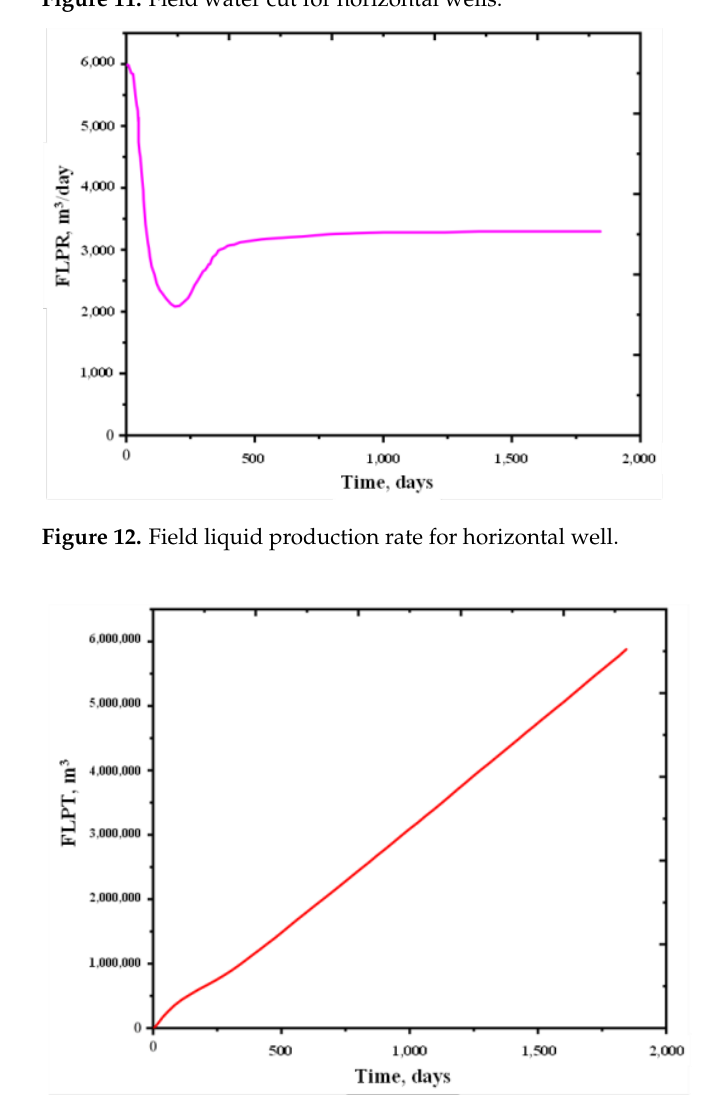
Figure 13. Field liquid production total for horizontal well.